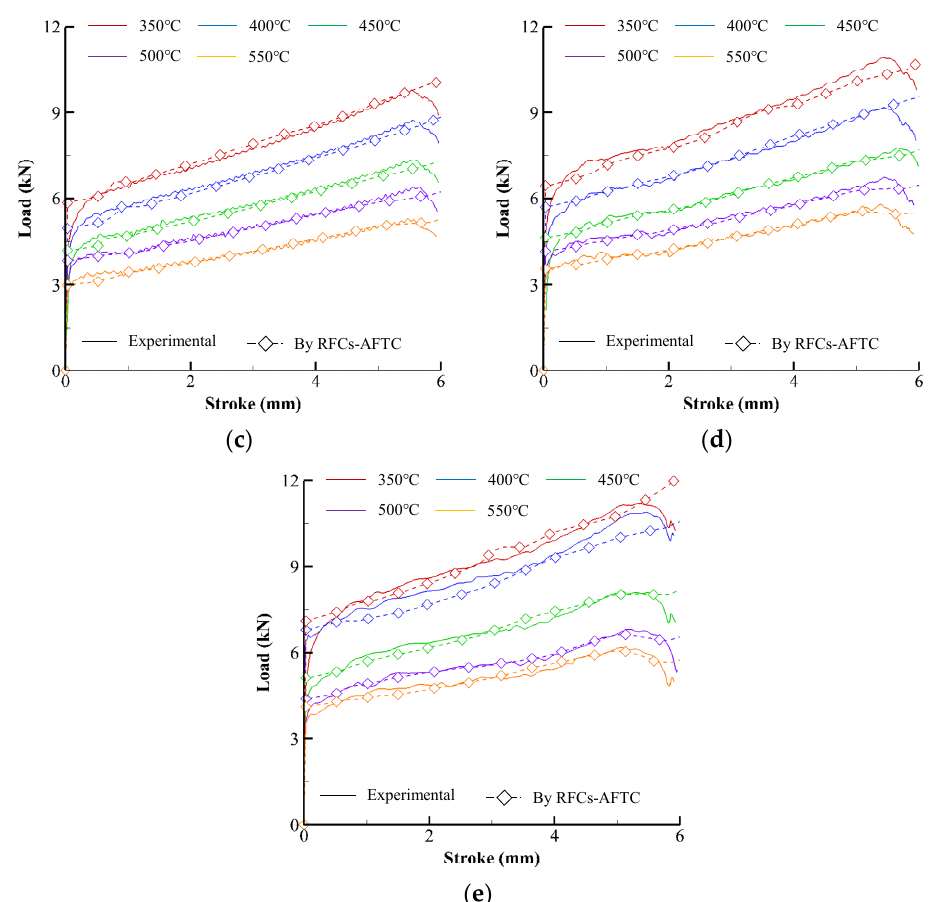
Figure 10. Experimental CLSCs and their predictions by RFCs–AFTCs: ( a ) 0.1 s − 1 , ( b ) 1 s − 1 , ( c ) 5 s − 1 , ( d ) 10 s − 1 , and ( e ) 20 s − 1 . Table 6. Error analysis of the CLSCs predicted by RFCs–AFTCs. Average Error for all Sample Strain Rates